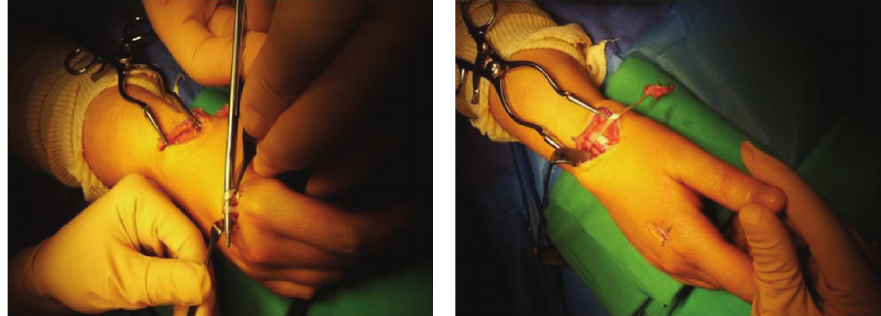
Figure 4: Taking of the extensor indicis proprius tendon by a second incision on the dorsal surface of the metacarpophalangeal joint of the index finger.